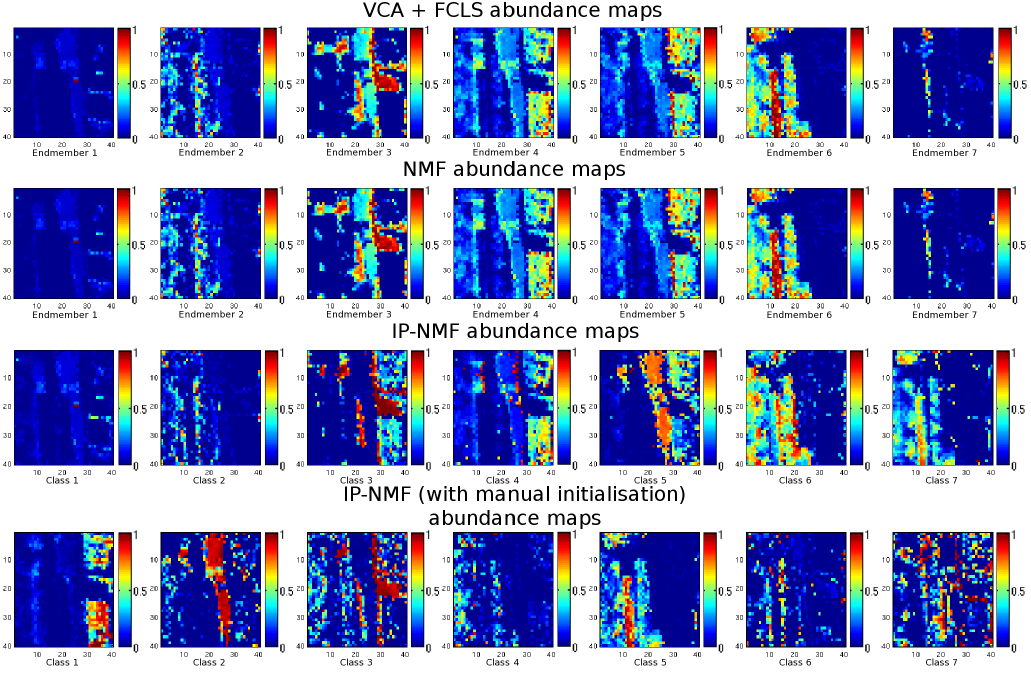
Figure 14. Abundance maps obtained for M = 7 with four methods: VCA + FCLS (1st line), standard NMF (2nd line), IP-NMF initialised with VCA (3rd line) and IP-NMF initialised with manually selected spectra (4th